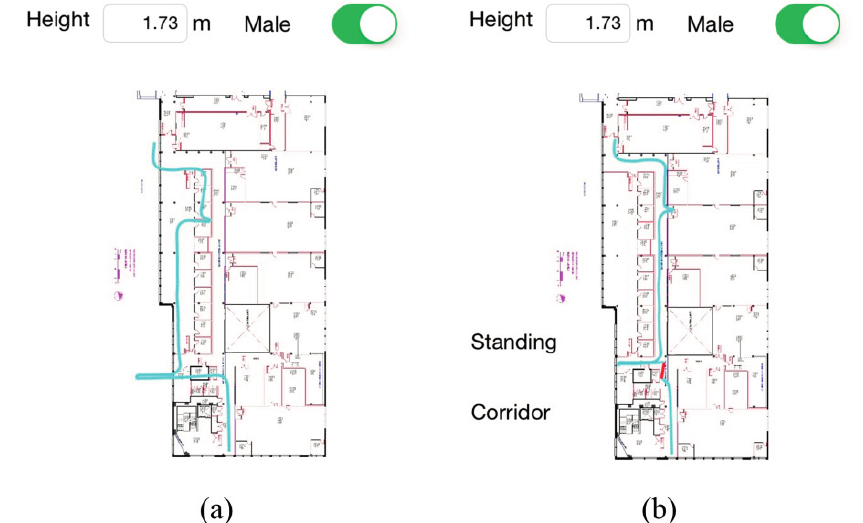
Figure 8. First short-term walking experiment result: ( a ) Path generated offline with the PDR standalone approach; ( b ) Path generated real-time by HILN